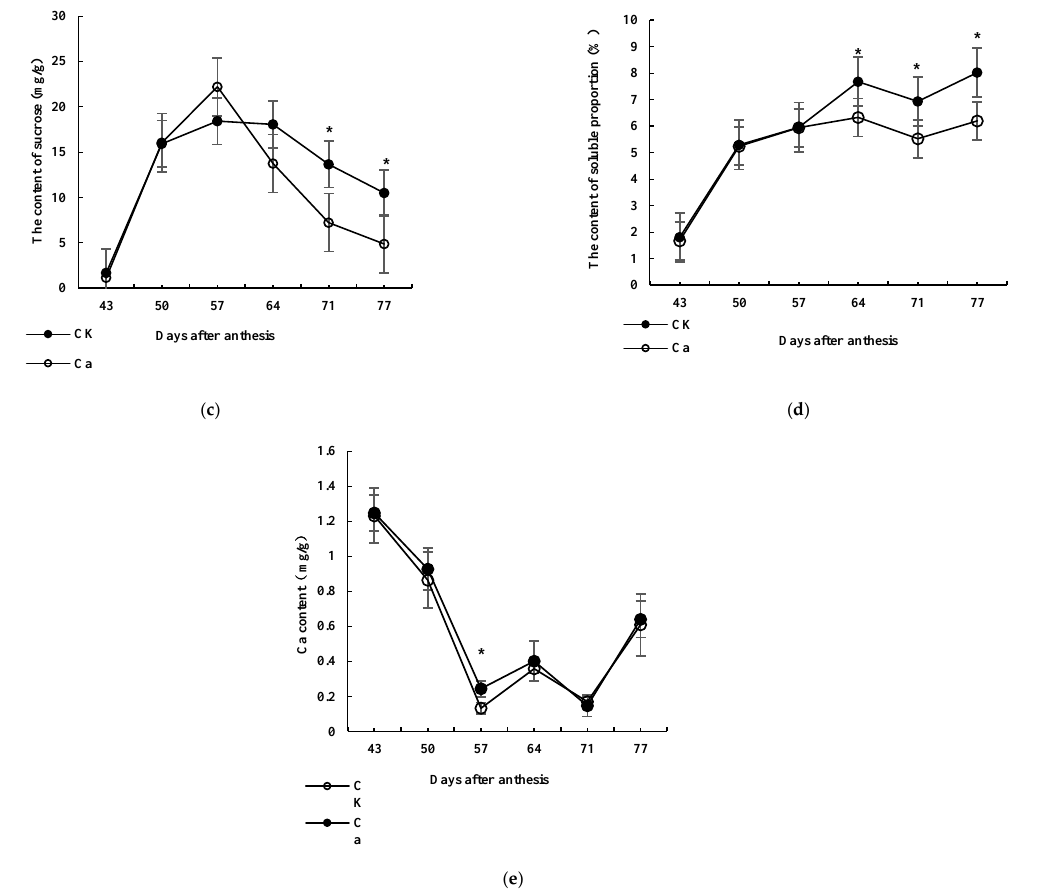
Figure 1. Effects of high-Ca treatment on sugar accumulation and Ca content: ( a ) content of glucose; ( b ) content of fructose; ( c ) content of sucrose; ( d ) content of soluble proportion; ( e ) content of Ca. Note: The symbols with * in the figure indicate significant differences between the CK and high-Ca treatments for the same data type; otherwise, there was no significant difference. The same scheme applies to the figures below.